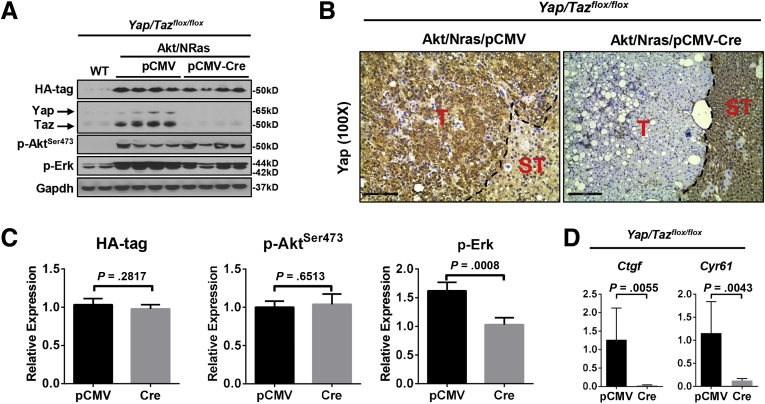
Molecular biological analysis of Yap and Taz-depleted Akt/NRas liver tumors. (A) Western blot analysis showing the expression levels of HA-tag, Yap/Taz, and activation of Akt and Ras pathways. Glyceraldehyde-3-phosphate dehydrogenase (Gapdh) was used as a loading control. (B) Immunohistochemical staining pattern of Yap in Yap/Tazflox/flox murine Akt/NRas liver tumors. Scale bar: 100 μm. (C) Quantification of HA-tag, p-AktSer473, and p-Erk1/2 expression in Yap/Tazflox/flox murine Akt/NRas/pCMV and Akt/NRas/pCMV-Cre liver tumors. (D) Expression of Ctgf and Cyr61 in Akt/NRas liver tumors developed in Yap/Tazflox/flox conditional knockout mice. T, tumor; ST, surrounding tissues.